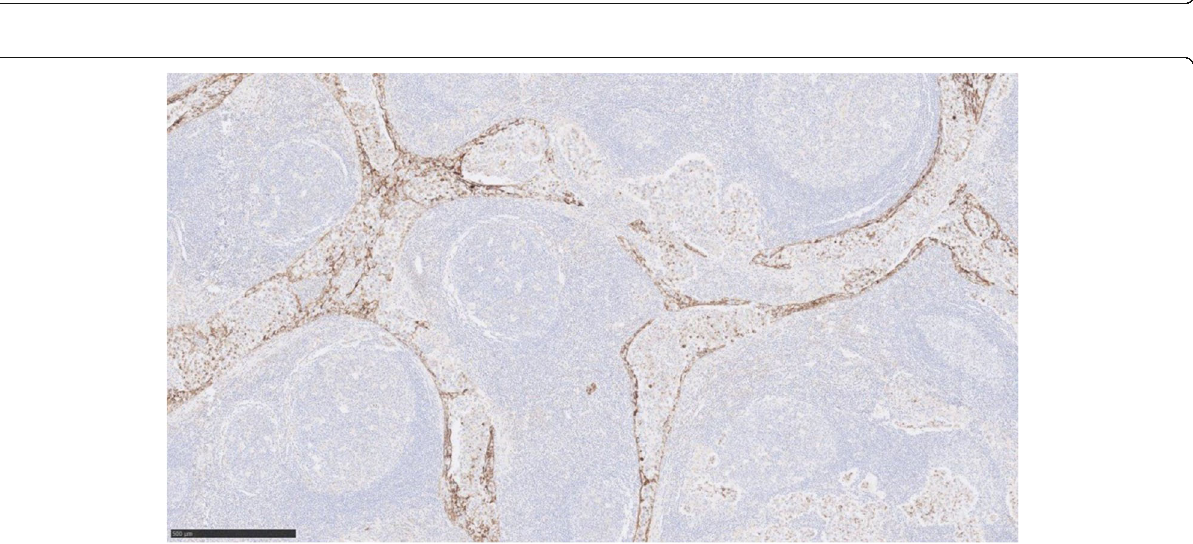
Fig. 3 H&E staining × 0.5 magnification (top) and high-resolution × 10 magnification (bottom)